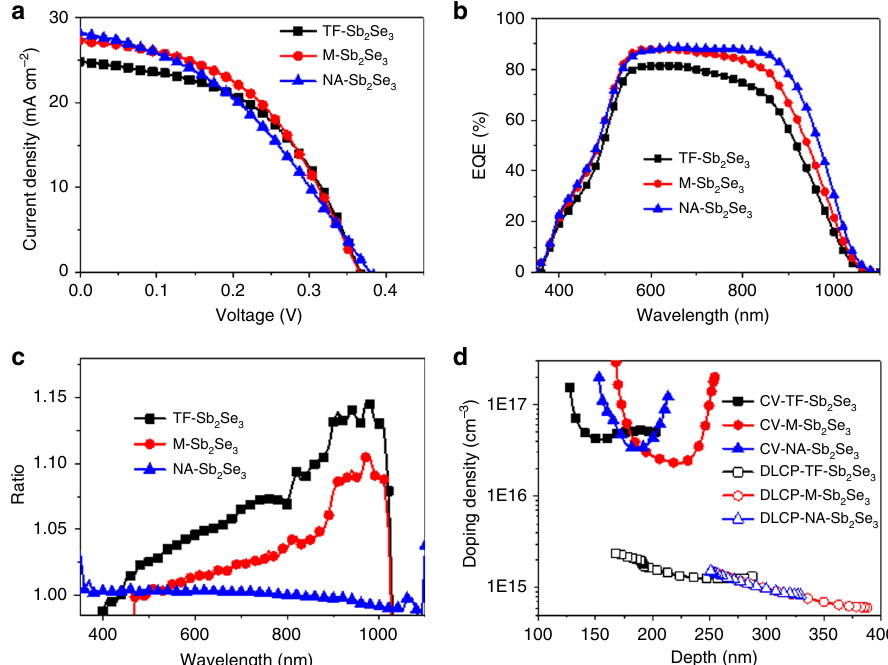
Fig. 4 Device performances of solar cells with different absorbers. a The representative J-V curves of the solar cells with different Sb 2 Se 3 absorbers. b , c EQE spectra and the ratio of EQE( − 0.5 V)/EQE(0V) curves of the solar cells. d C-V pro fi ling and DLCP pro fi ling of the solar cells